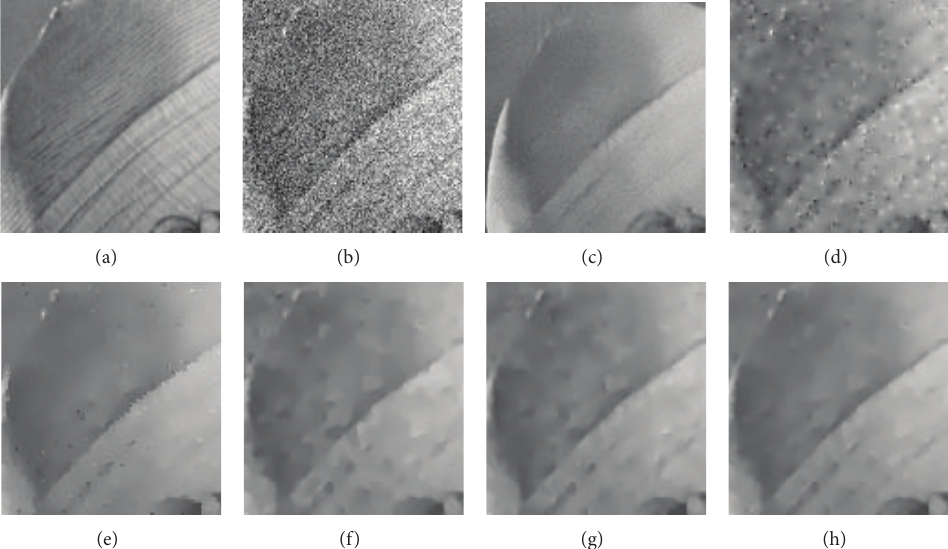
Figure 6: A part of the results of the lena image by the five models: (a) original image, (b) noisy image, (c) result by NLM, (d) result by Y-K model, (e) result by PM, (f) result by TV, (g) result by MTV, and (h) result by our